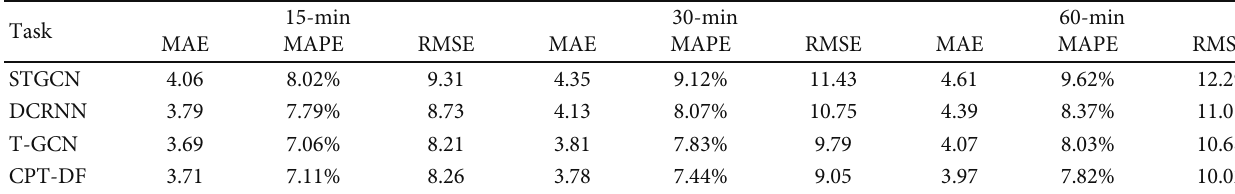
Table 3: Comparison of the performance of spatiotemporal prediction.